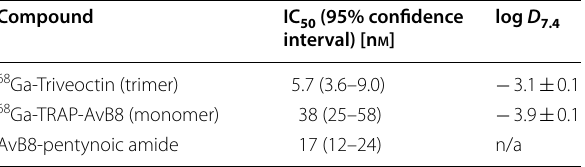
Table 1 αvβ8-Integrin affinities (expressed